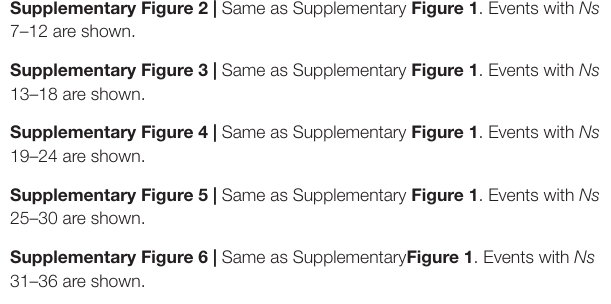
Supplementary Figure 1 | Focal mechanism solutions obtained, respectively with the average, the minimum and the maximum velocity model. Ns is the identification number for each solution. Events with Ns 1–6 are shown. Supplementary Figure 2 | Same as Supplementary Figure 1 . Events with Ns 7–12 are shown. Supplementary Figure 3 | Same as Supplementary Figure 1 . Events with Ns 13–18 are shown. Supplementary Figure 4 | Same as Supplementary Figure 1 . Events with Ns 19–24 are shown. Supplementary Figure 5 | Same as Supplementary Figure 1 . Events with Ns 25–30 are shown. Supplementary Figure 6 | Same as Supplementary Figure 1 . Events with Ns 31–36 are